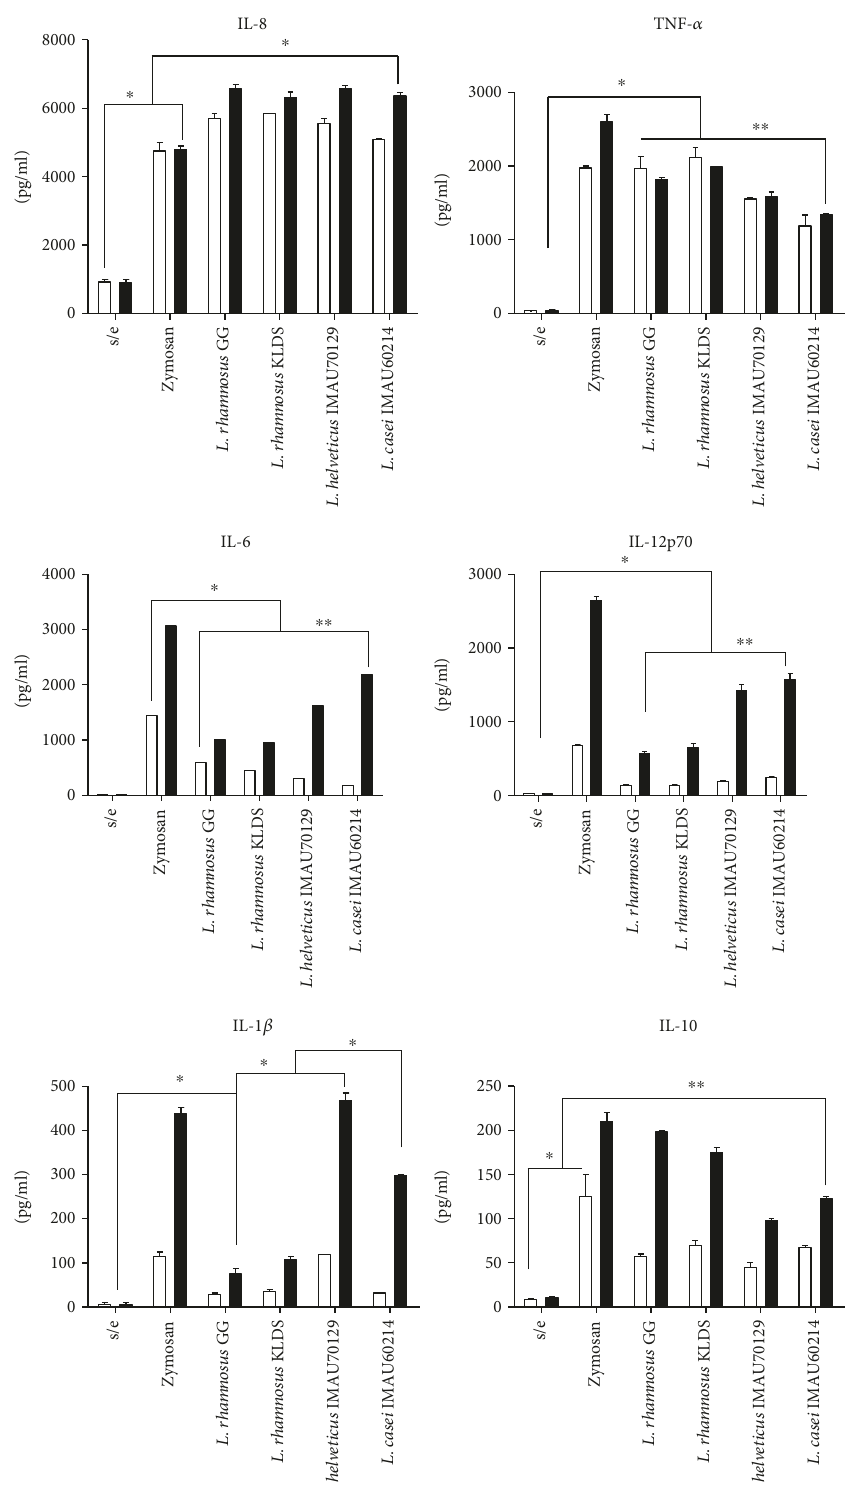
Figure 2: Cytokine production in human macrophages that were stimulated using heat-killed lactobacillus. The supernatants of stimulated macrophages were analyzed using ELISA to determine the level of expression of the cytokines IL-8, TNF- α , IL-6, IL-12, IL-1 β , and IL- 10. The macrophages were treated with zymosan (10 μ g/ml) or heat-killed strains of lactobacillus at a MOI of 1 :500 or untreated (s/e). Cytokine concentrations were determined at 6h ( □ ) and 24h ( ■ ) after stimulation. The results are shown as the means ± of the standard deviations and are representative of four independent experiments. Signi fi cance was set at p < 0 05 ( ∗ ) in the comparison between 6 and 24 h of stimulation. p > 0 05 ( ∗∗